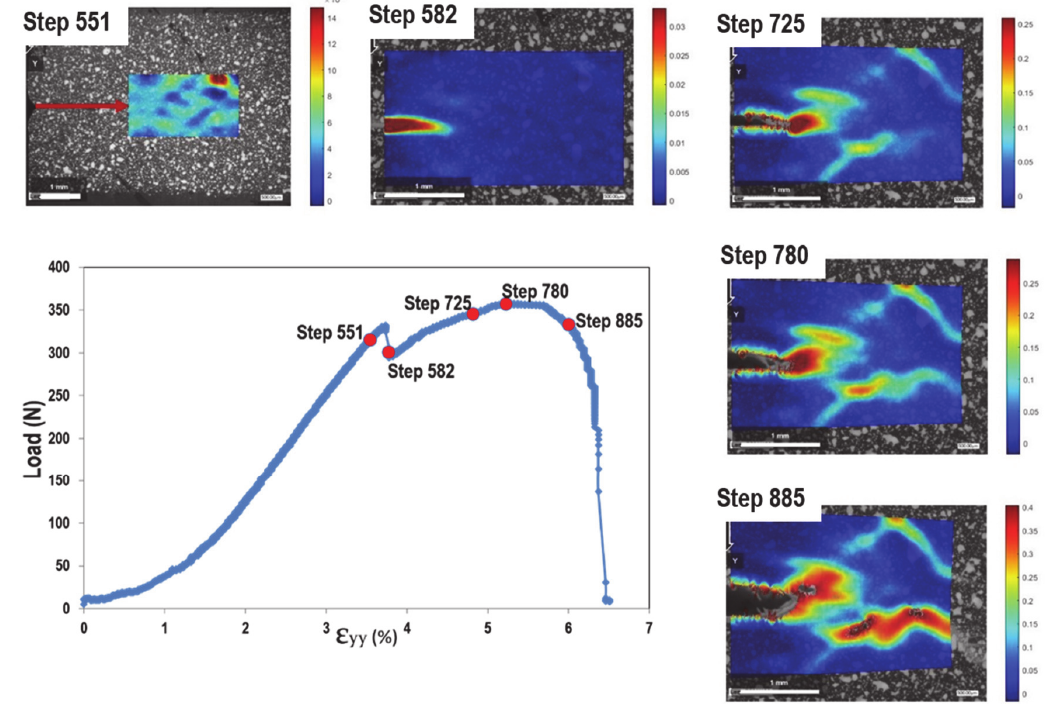
Figure 3: Quantitative analysis of strain evolutions. Step 551 shows the region where the strains are analyzed in front of the design notch materialized by the red arrow. The scale bar at each image is 1